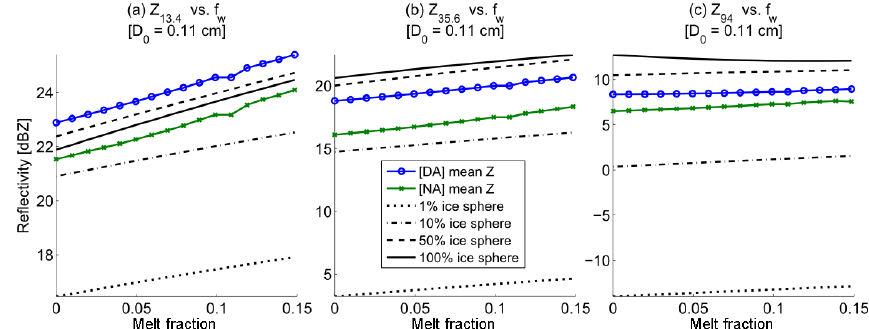
Figure 11. Simulated radar reflectivities at (a) 13.4, (b) 35.6, and (c) 94GHz. Reflectivities were computed by integrating over the orientation- averaged single-particle backscattering cross sections, assuming an exponential particle size distribution, for both aggregates and spheres. The reflectivities are presented only for one value of D 0 = 0 . 11cm (i.e., the liquid-equivalent median volume diameter). N 0 and D 0 are computed following Sekhon and Srivastava, 1970 (see text). Note different scaling on the vertical